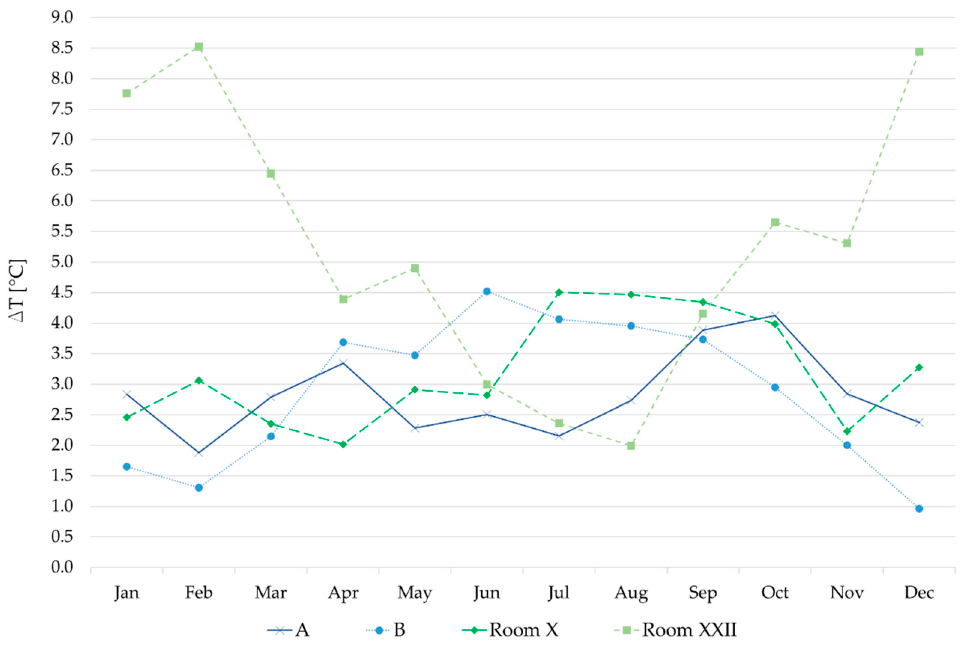
Figure 28. Trend of monthly temperature difference between indoor and outdoor for the analyzed zones of Vasari Corridor and La Specola museum. zones of Vasari Corridor and La Specola